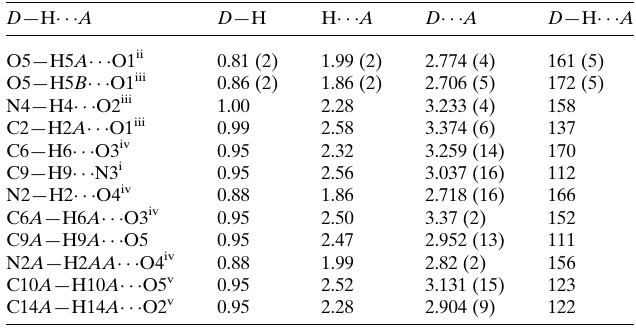
Figure 1 The coordination environment within the title compound, showing octahedral coordination at the Ni II cation. Displacement ellipsoids are drawn at the 50% probability level. All non-H atoms are labeled. Both disorder components of the dpa ligands are shown. Color code: Ni, green; N, blue; O, red; C, black; H, pink. Symmetry code: (i) (cid:4) x , y (cid:4) 1